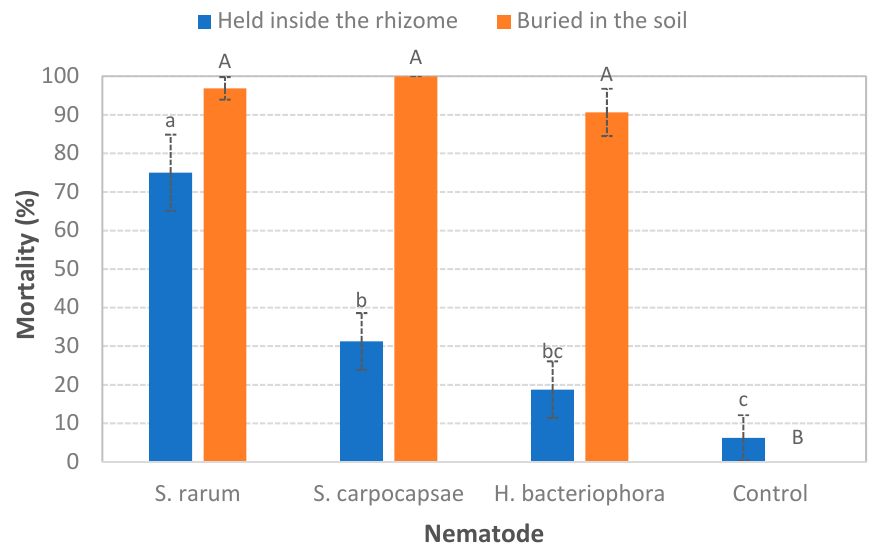
Figure 3. Mortality of Galleria mellonella larvae caused by entomopathogenic nematodes seven days after application. Held inside the rhizome = larvae held inside the cane rhizome. Buried in the soil = larvae buried in the soil, outside the cane rhizome. Means followed by different upper- or lower-case letters differ significantly within categories according to Tukey’s test ( p < 0.05). For S. levis larvae held inside the rhizome, S. rarum also exhibited the highest viru- lence (78.1%), though not differing from S. carpocapsae (56.2%), but differing from H. bac- teriophora (28.1%) and the control (3.1%) (F 3, 56 = 28.96; p < 0.001) (Figure 4).